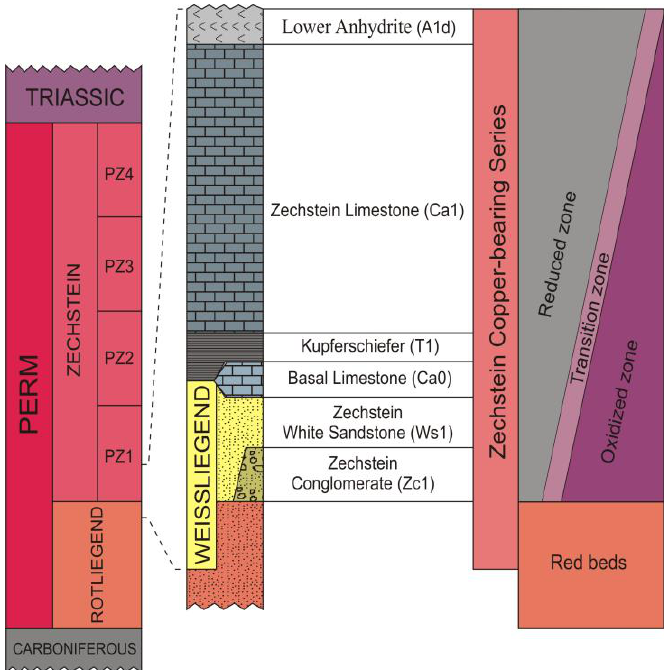
Figure 7. Stratigraphic position of the Zechstein copper-bearing series and distribution chart of geochemical zones that cut across the strata.